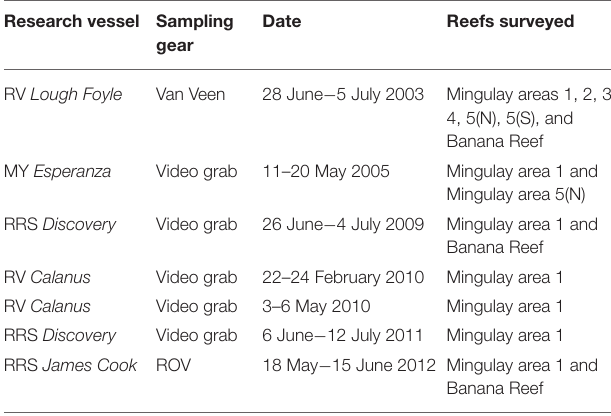
TABLE 1 | List of historic research cruises for which the systematic review of marine litter was conducted for the East Mingulay MPA. Research vessel Sampling